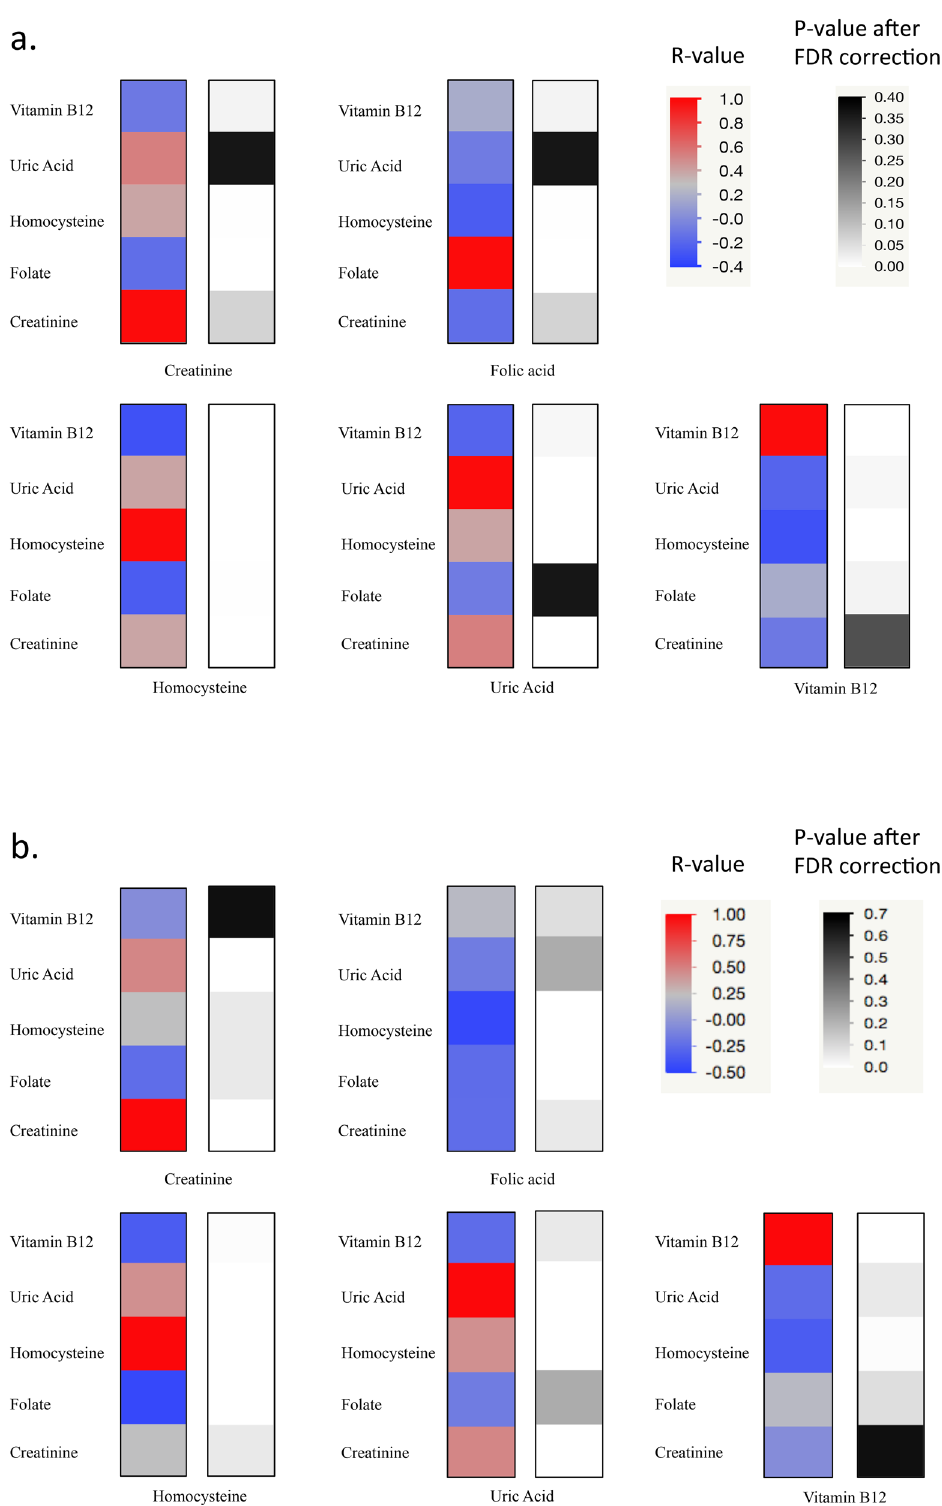
Figure 3. Heat Map of the metabolite level correlations among each other. ( a ) Partial correlation controlled by age at blood draw between the metabolite levels among each other. The analysis includes outliers. ( b ) Partial correlation controlled by age at blood draw between the metabolite levels among each other. The analysis excludes strong